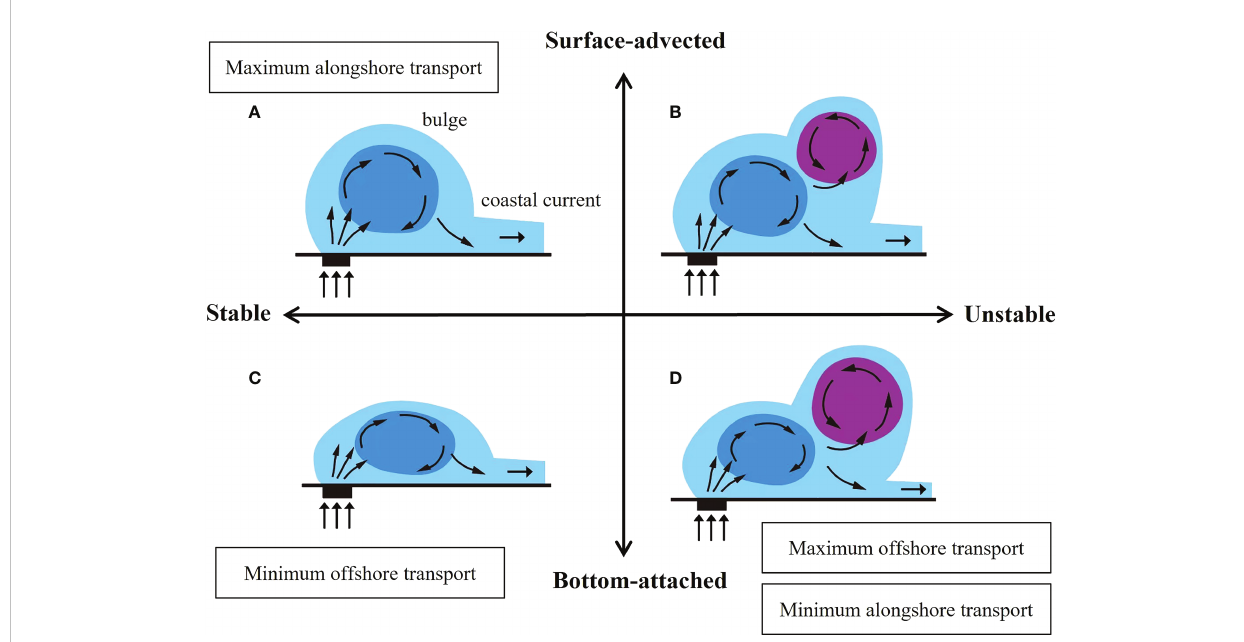
FIGURE 13 Schematic diagram to show the effects of bottom attachment and bulge instability on freshwater transport in the alongshore and offshore direction. (A – D) show stable surface-advected, unstable surface-advected, stable bottom-attached, and unstable bottom-attached plumes,